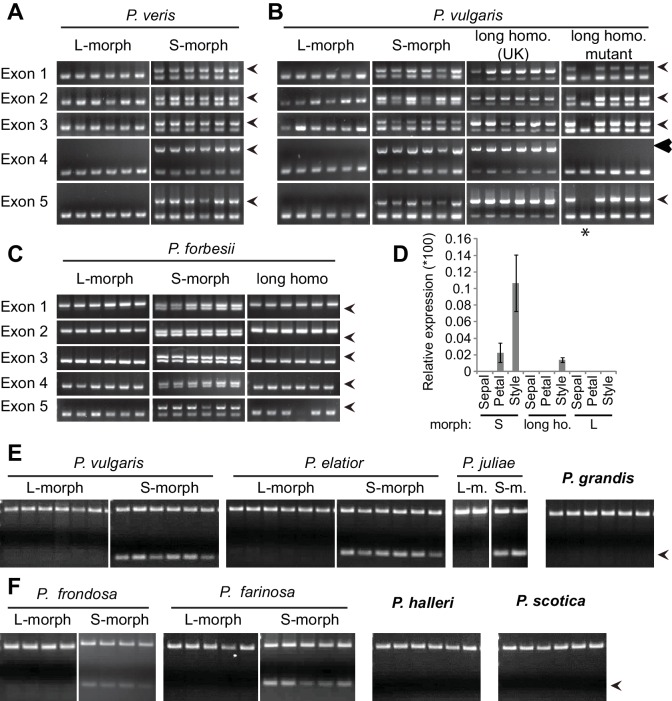
Co-segregation of CYP734A50 with the style phenotype.(A–C) PCR-genotyping of individuals with the indicated phenotypes of P. veris (A), P. vulgaris (B) and P. forbesii (C). ‘Long homo (UK)’ are naturally occurring long homostyles from England; ‘long homo mutant’ are long homostyles from the commercially grown population. ‘Long homo’ P. forbesii are long-homostylous putative recombinants found in our experimental population. Multiplex PCR amplified CYP734A50 exons (arrowheads) and ITS as an internal control. Enlarged arrowhead marks absence of exon 4 in the mutant. Asterisk in (B) marks a segregating L-morph individual. (D) Expression of CYP734A50 in dissected floral organs of naturally occurring long homostyles, S- and L-morphs of P. vulgaris, normalized to α-TUBULIN. Values are mean ± SD from three biological replicates. (E,F) PCR-genotyping of individuals with the indicated phenotypes from species in Primula sect. Primula (E) and Primula sect. Aleuritia (F). Long homostylous species are indicated in bold. Multiplex PCR was performed using primers to amplify exon 3 of CYP734A50 (arrowhead) and ITS as an internal control. Full gel images are shown in Figure 2—figure supplement 2. Specificity of PCR amplification for CYP734A50 is shown in Figure 2—figure supplement 3. Each set of plants was genotyped at least twice independently.DOI:
http://dx.doi.org/10.7554/eLife.17956.00810.7554/eLife.17956.009Figure 2—source data 1.Read counts from Illumina whole-genome sequencing of S- and L-morph plants of P. vulgaris and P. forbesii.Reads were mapped to the exons of CYP734A50 and CYP734A51 including the 200 surrounding intronic nucleotides (± 100 bp). Absolute read counts are given. Due to the very similar target lengths for mapping against both genes, absolute read counts can be directly compared. All P. vulgaris samples are from the SRA project deposited under http://www.ncbi.nlm.nih.gov/bioproject/PRJEB9683.